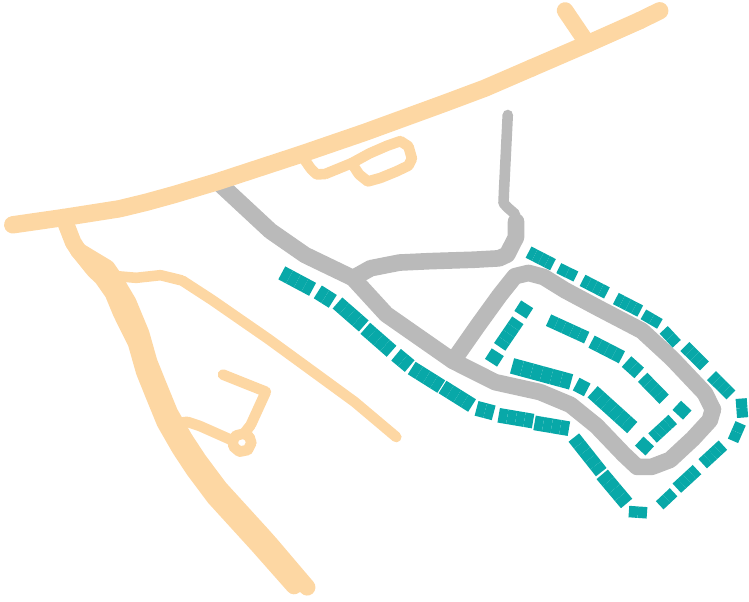
Figure 1. A set of polygons corresponding to houses in a housing estate and a number of lines corresponding to roads are represented. The grey line represents the access road for the housing estate in question. Data taken from